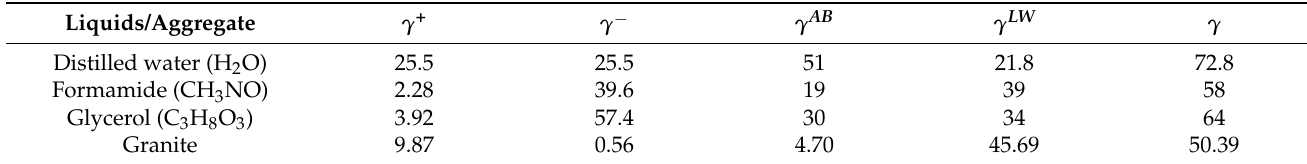
Table 3. Surface free-energy parameters of chemical droplets and aggregate.